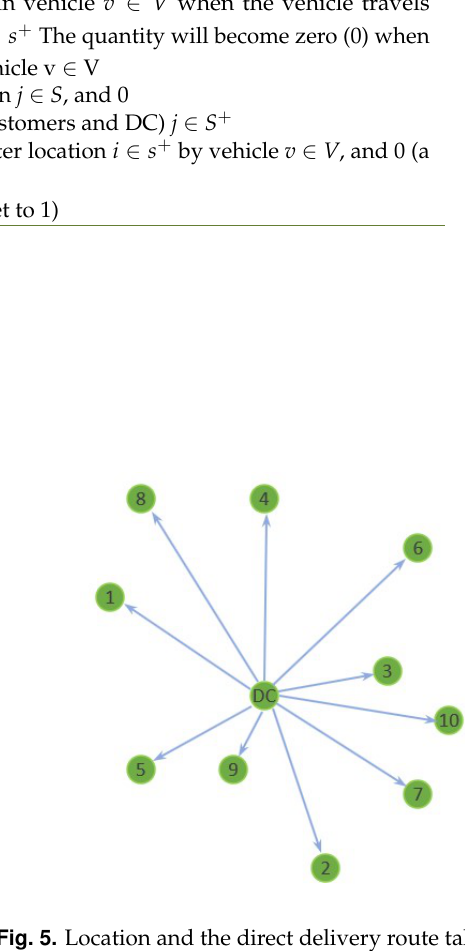
Fig. 5. Location and the direct delivery route taken by the vehicle (10